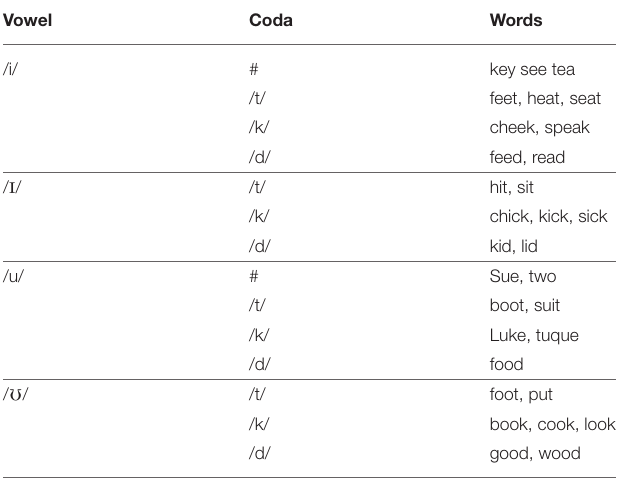
TABLE 1 | Target words from the picture-naming